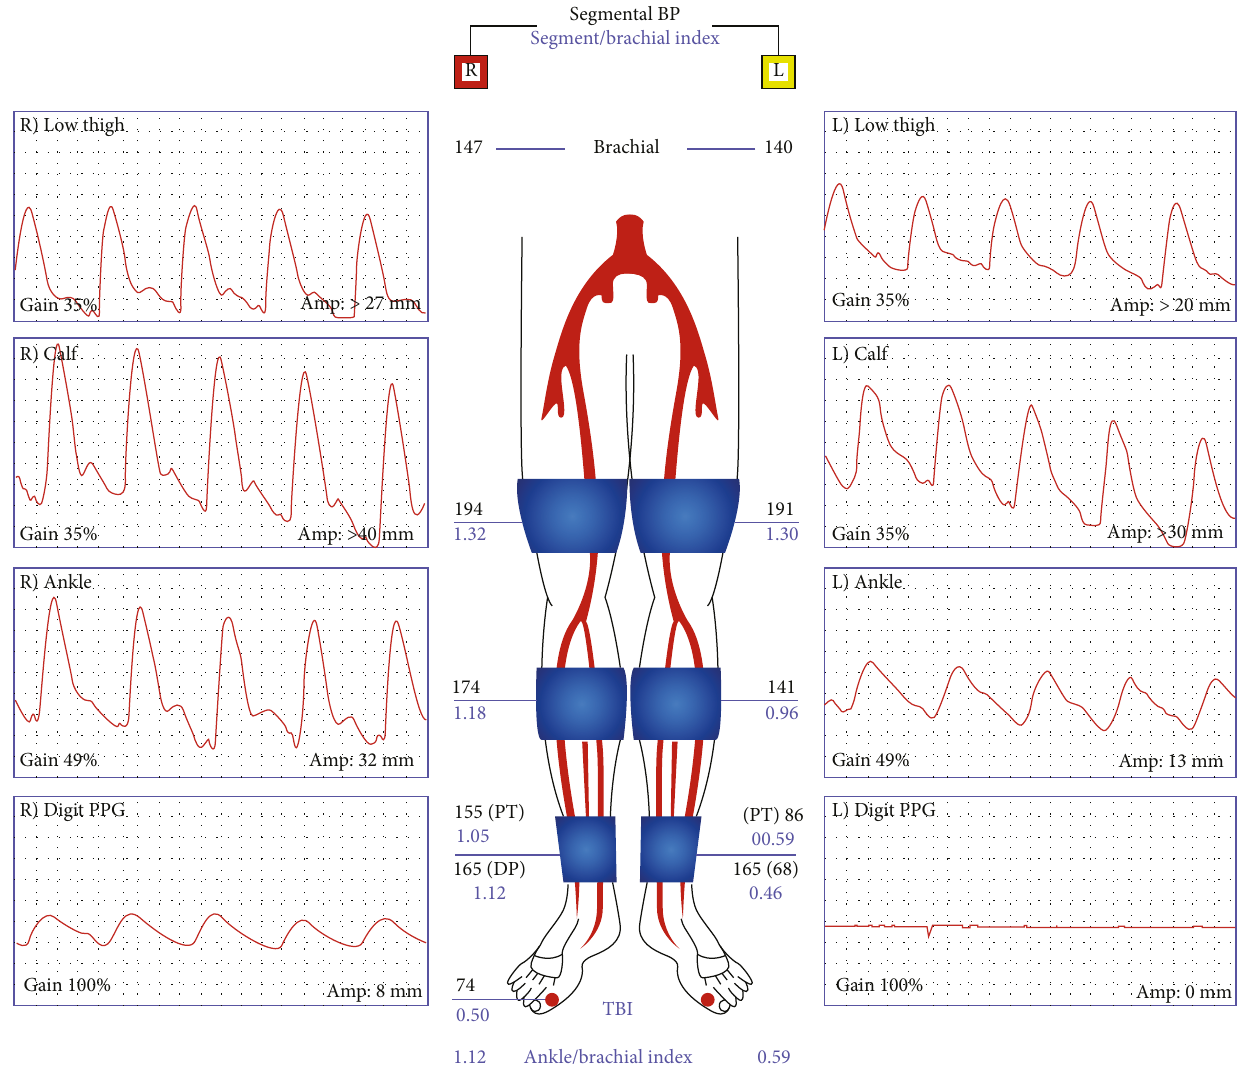
Figure 5: Lower extremity arterial Doppler with signi fi cant fl ow limitations in the left lower extremity consistent with di ff use obstructive atherosclerotic obstructive disease in the left posterior tibial artery, peroneal artery, and anterior tibial artery. The waveforms of the right lower extremity are normal multiphasic Doppler waveforms. In the left extremity, we see dampened monophasic Doppler fl ow signals in the area of the left posterior tibial artery and dorsalis pedis artery. Diminished pulse volume recordings were seen in the left ankle. Flat line, nonpulsatile fl ow signals were seen in the digits of the left foot.